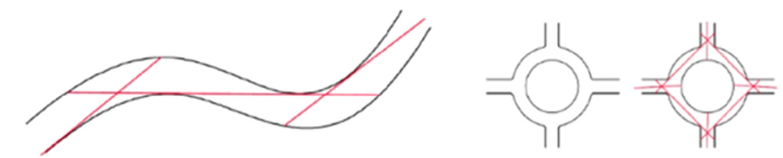
Figure 5. Basic principles of axis drawing.